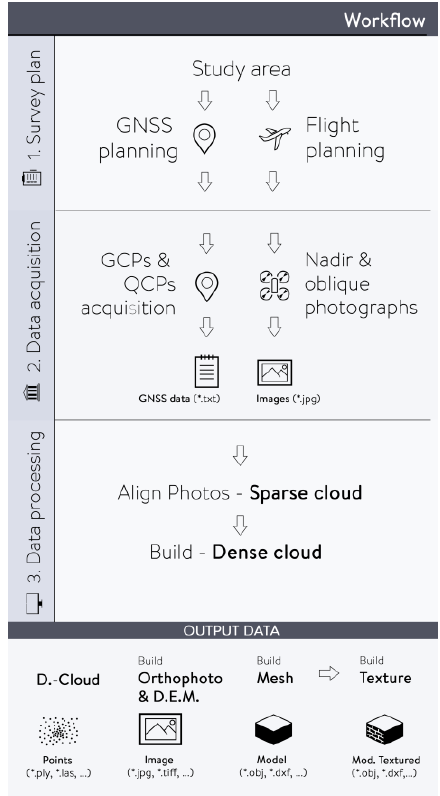
Figure 1. The temple of Sardus Pater Babai in the Antas valley